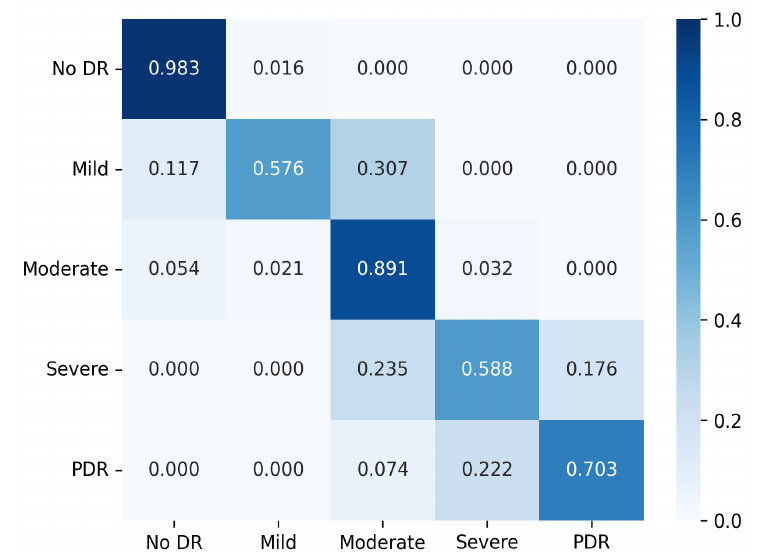
Figure 4. Confusion matrix for the presented method on APTOS dataset with normalization applied.